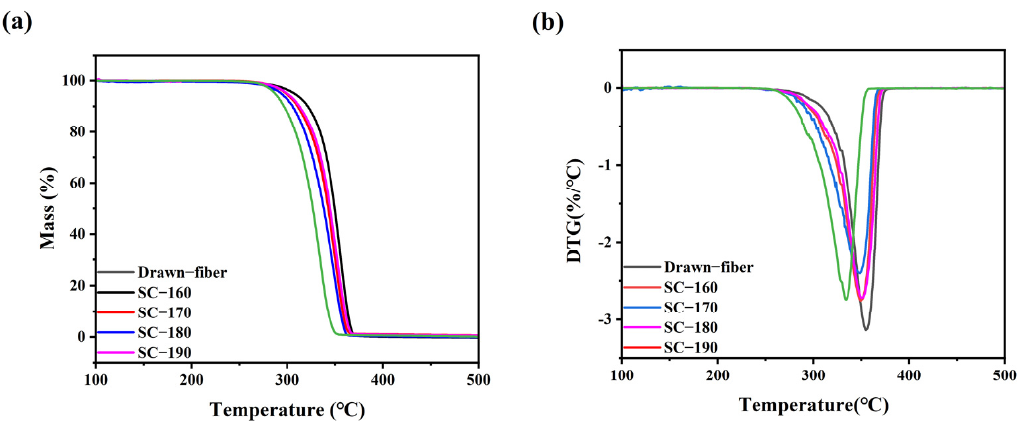
Figure 4. ( a ) TGA and ( b ) DTG curves of drawn − fiber and SC − PLA